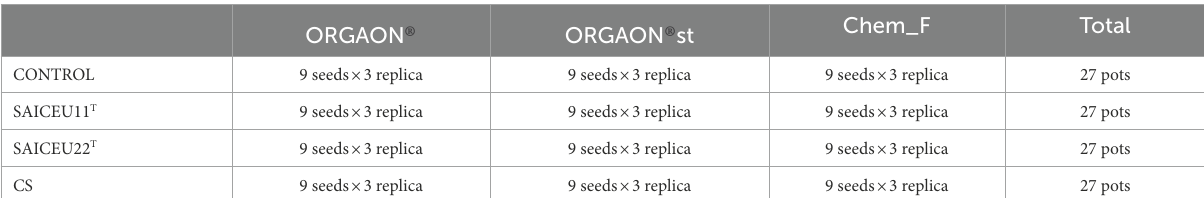
TABLE 3 Experimental